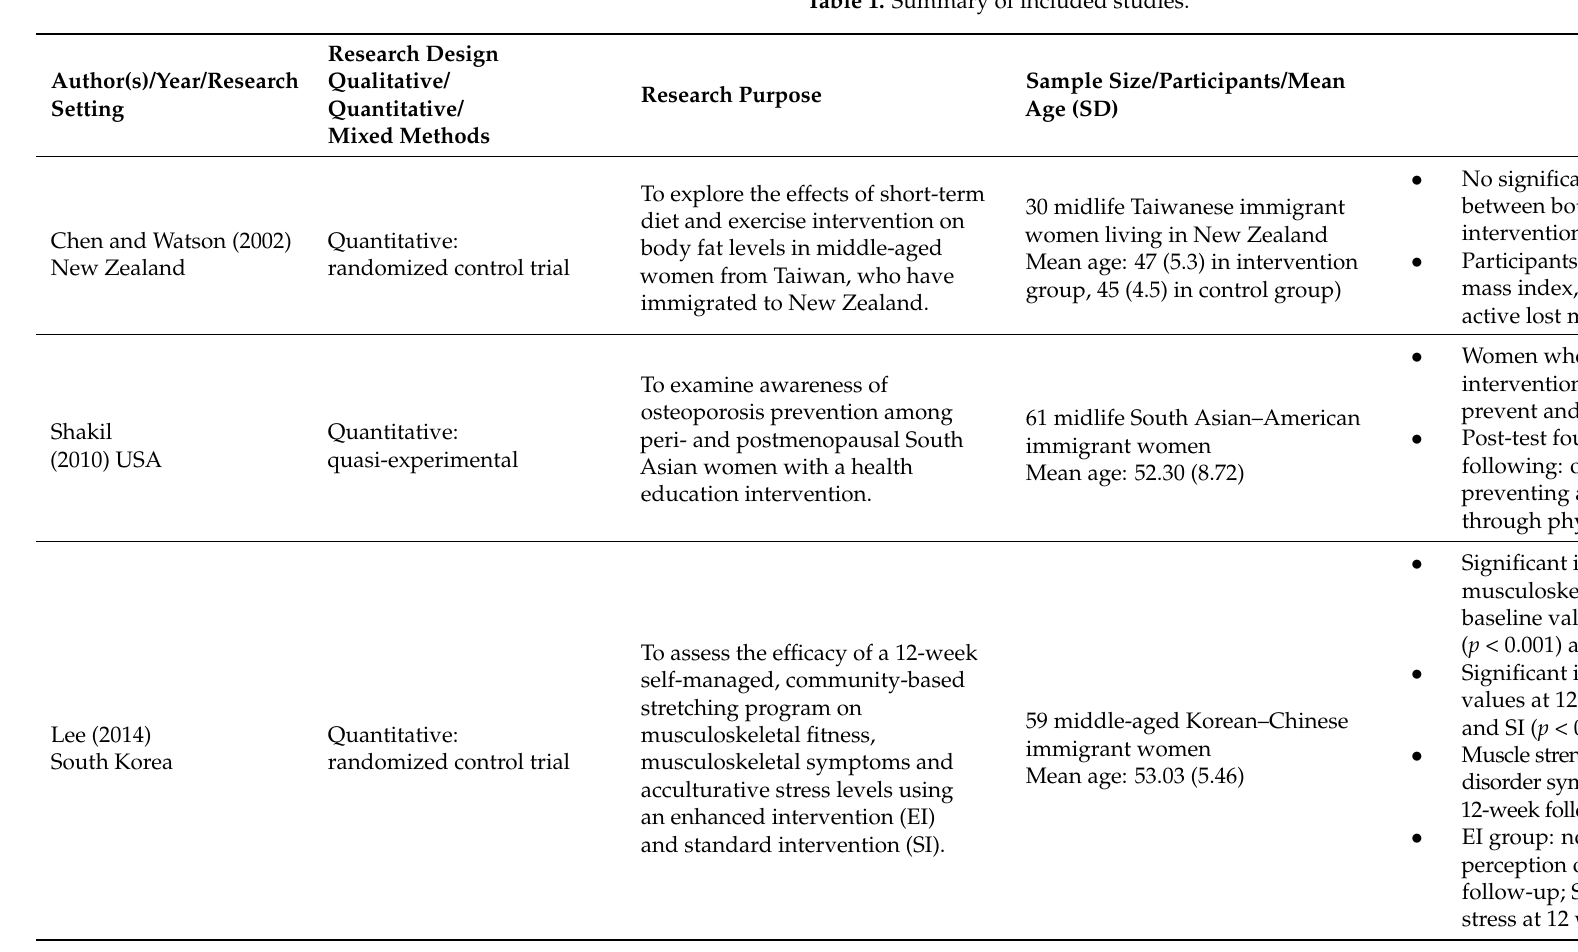
Table 1. Summary of included